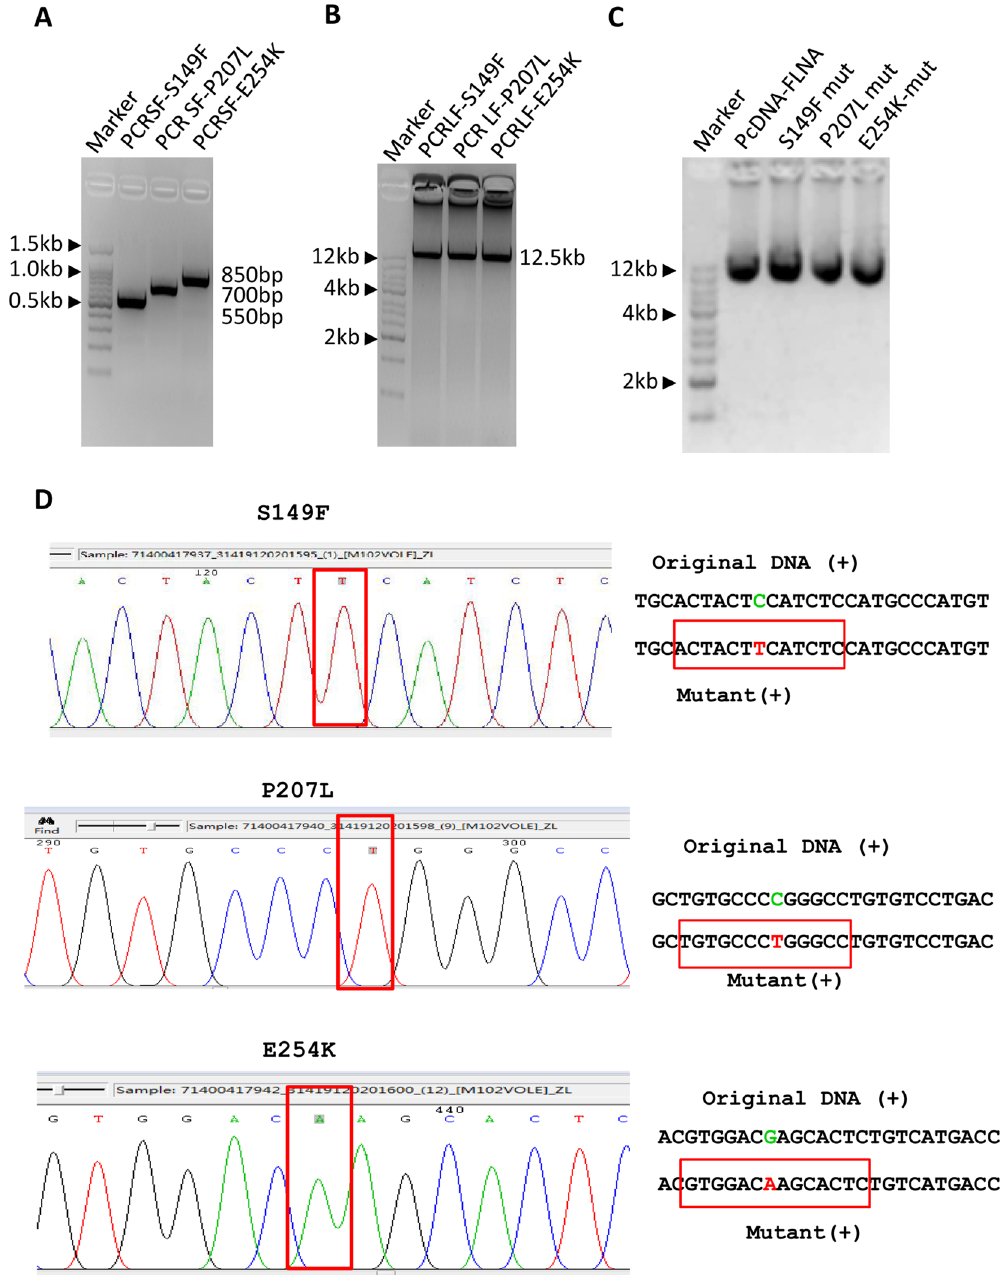
Figure 4. The SMLP method showed consistent results in the mutagenesis of large plasmids. ( A ) Analysis of the small DNA fragments from PCR by agarose gel electrophoresis. PCR was performed using the primer pcDNAFP and one of the mutation reverse primers, including S149FRP, P207LRP, and E254KRP, where the pcDNA-FLNA plasmids acted as DNA templates. PCR products were monitored by agarose gel electrophoresis. PCRSF represents PCR small fragments. ( B ) Analysis of the large DNA fragments from PCR by agarose gel electrophoresis. PCR was performed using the primer pcDNARP and one of the mutated forward primers, including S149FFP, P207LFP, and E254KFP, where the pcDNA-FLNA plasmids acted as DNA templates. PCR products were monitored by agarose gel electrophoresis. PCRLF represents PCR large fragments. ( C ) Analysis of the pcDNA-FLNA plasmids from site-directed mutagenesis by agarose gel electrophoresis. The plasmids from mutagenesis were prepared and analysed by agarose gel electrophoresis. ( D ) The results of DNA sequencing for S149F, P207L, and E254K mutants. The DNA sequencing maps for the S149F, P207L, and E254K mutants were presented at the left, where the mutated bases were outlined by the red rectangle lines. The right panels are the original and mutated DNA sequences for each mutant, where the bases in the sequencing map were framed by the red rectangle lines. The original and mutated bases were displayed in green and red colours,